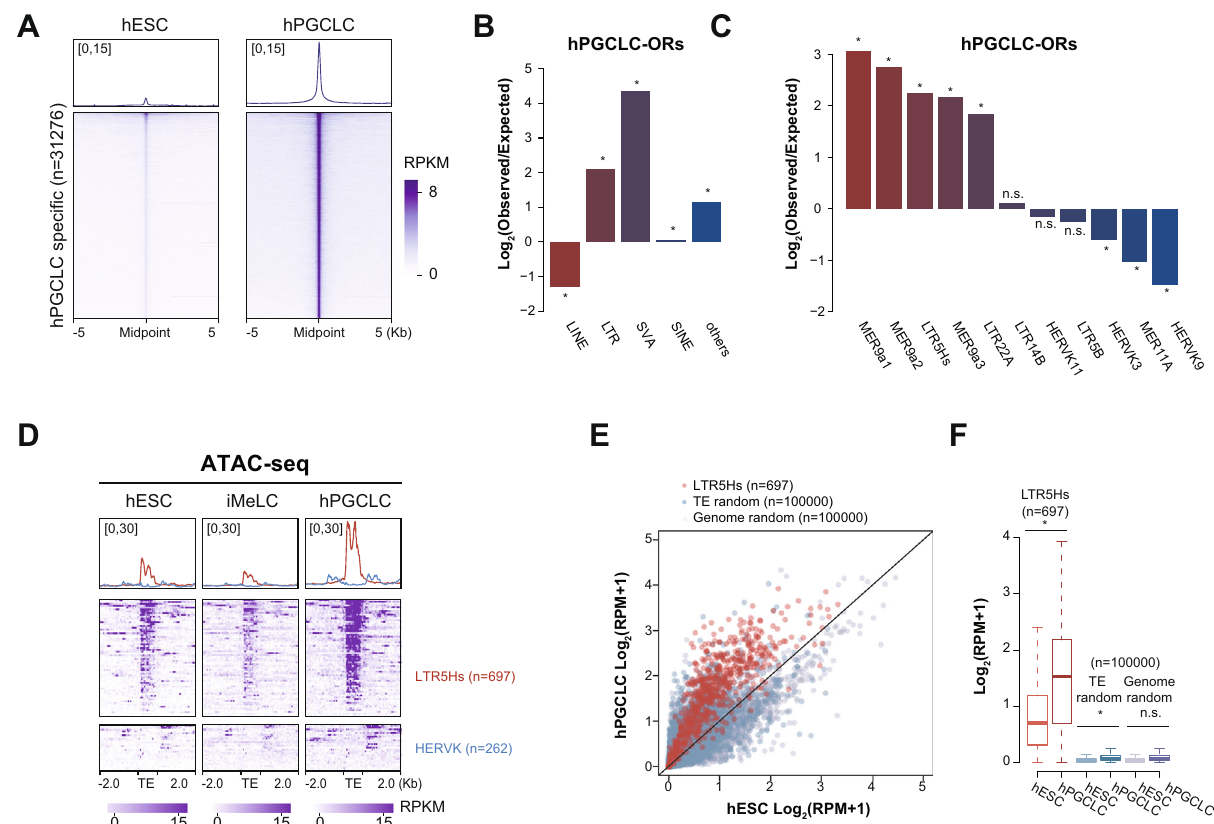
Fig. 2 Increased chromatin accessibility over LTR5Hs with hPGCLC induction. A Heatmap and metaplot for ATAC-seq signals over hPGCLC-ORs ( n = 31276). B , C Enrichment of TE classes ( B ), and TE subfamilies within the ERVK family ( C ) for hPGCLC-ORs over random shuf fl ed regions with comparable genomic distributions (* p -value < 0.05, binomial test; n.s. = not signi fi cant). D Heatmap and metaplot of ATAC-seq signals over all LTR5Hs ( n = 697) and HERVK copies ( n = 262) in hESCs, iMeLCs, and hPGCLCs. E , F Scatterplot ( E ) and boxplot ( F ) of ATAC-seq signals over LTR5Hs, randomly shuf fl ed TE and genomic regions in hESCs and hPGCLCs (* p -value < 0.05, Welch Two Sample t -test; n.s. = not signi fi cant). In F the middle line represents the median; boxes represent the 25th (bottom) and 75th (top) percentiles; and whiskers represent the minimum and maximum points within 1.5× the interquartile range. Source data underlying B , C , and F are provided as a Source Data fi